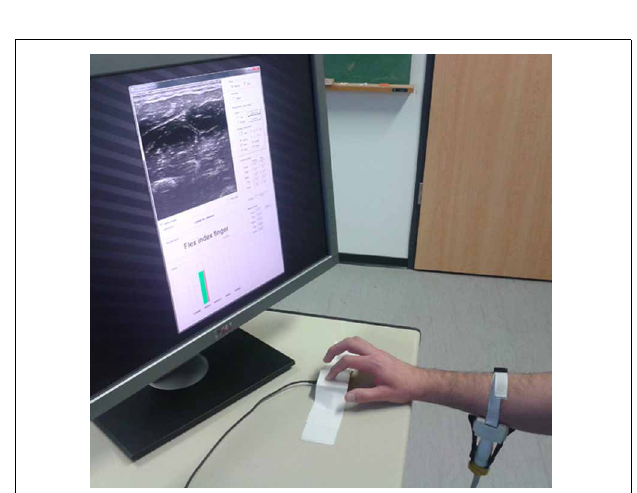
FIGURE 3 | A bird’s eye view of the setup. The subject sits in front of a screen on which the stimulus is shown; meanwhile force data and US images are